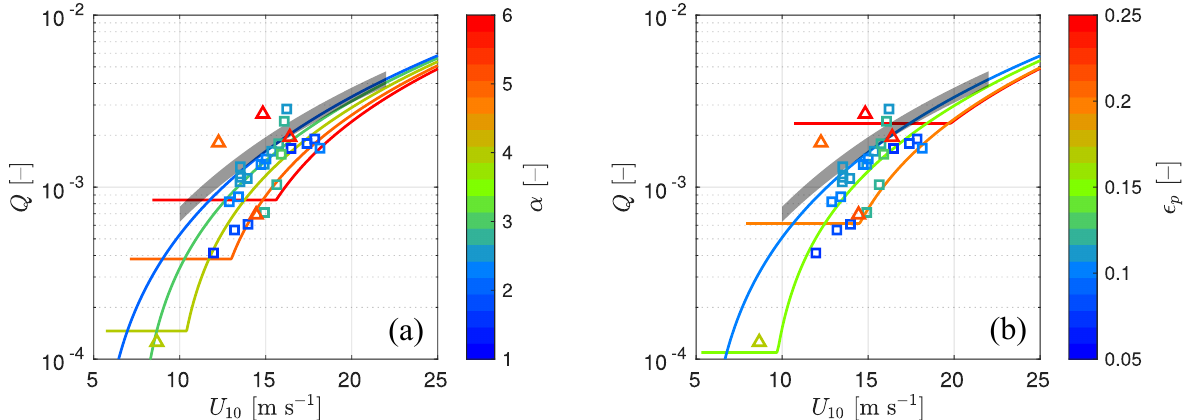
Figure 11. ( a ). The semi-empirical total active whitecap coverage, Q , as a function of the wind speed, U 10 , for different inverse wave ages, α . ( b ) The same, but for different dominant wave steepness, (cid:101) p . Markers represent our experimental estimates of Q . Squares and triangles correspond to the onshore- and offshore-wind conditions, respectively. A thick gray line indicates the parameterization of